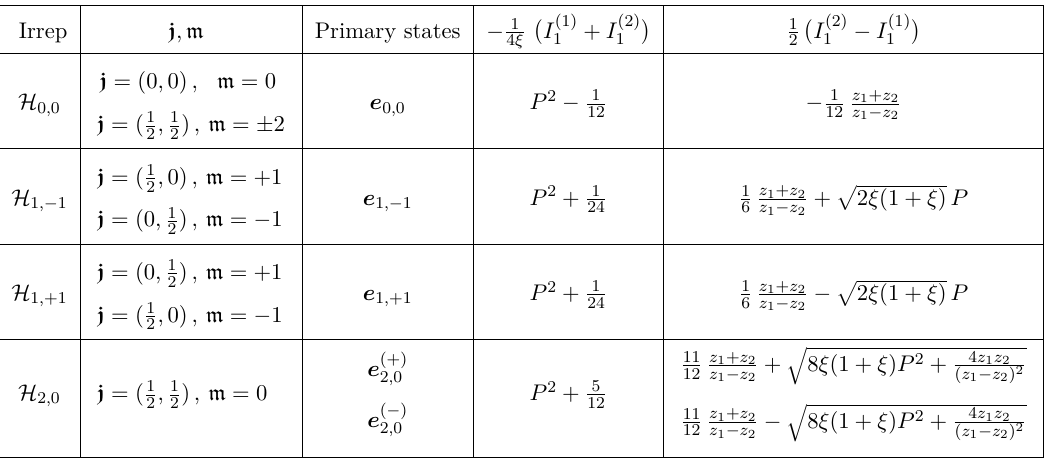
Table 1 . The algebra W ( c, 2) possesses four inequivalent representations, whose corresponding 1 values of j = ( j 1 , j 2 ) and m are listed in the second column. Given in the table are the eigenvalues of the symmetric and anti-symmetric combinations of the local IM I (1) , I (2) for the primary states 1 1 from these representations. The eigenvalues were computed using eq. (8.22), which itself comes from the analysis of the ODE (7.48), (7.44) specialized to the case r = 2 and k 1 = k 2 = 1 . The realization of the primary states in the bosonic and fermionic modules is described by eqs. (9.30) and